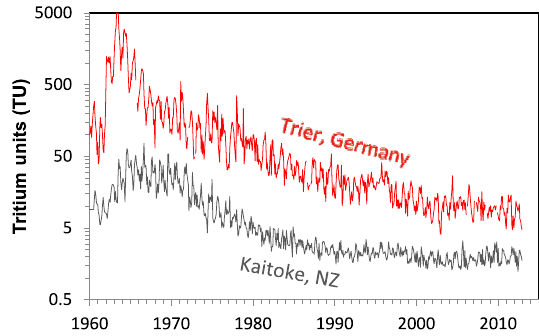
Figure 1. Tritium concentrations (TU) in monthly precipitation samples at Kaitoke, New Zealand, in the Southern Hemisphere, and Trier, Germany, in the Northern